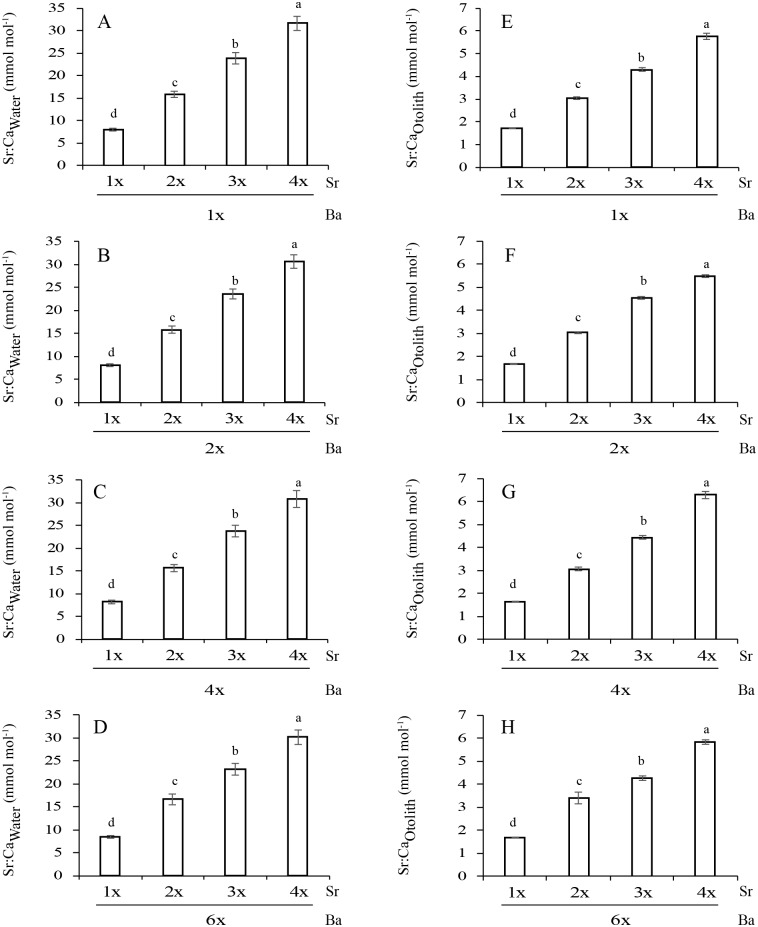
Measured Sr concentrations (mean±SD) in water (Sr:CaWater, A-D) and otoliths (Sr:CaOtolith, E-H) across treatments (two-way ANOVA, P<0.05).